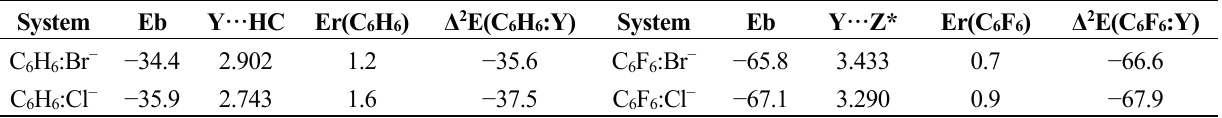
Z* represents the middle of one of the C-C bonds of the aromatic system.